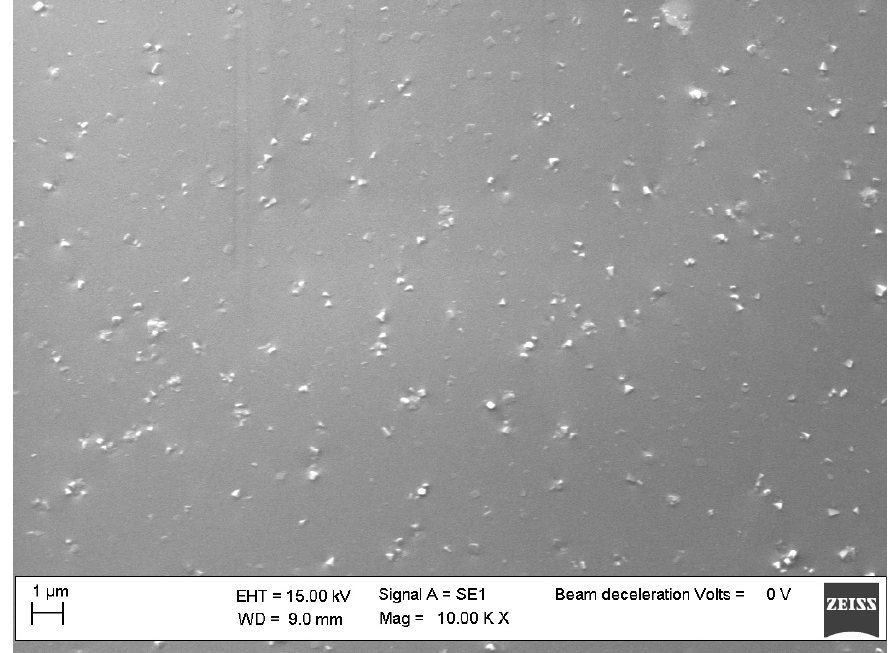
Figure 11. SEM micrographs of sample 4 .